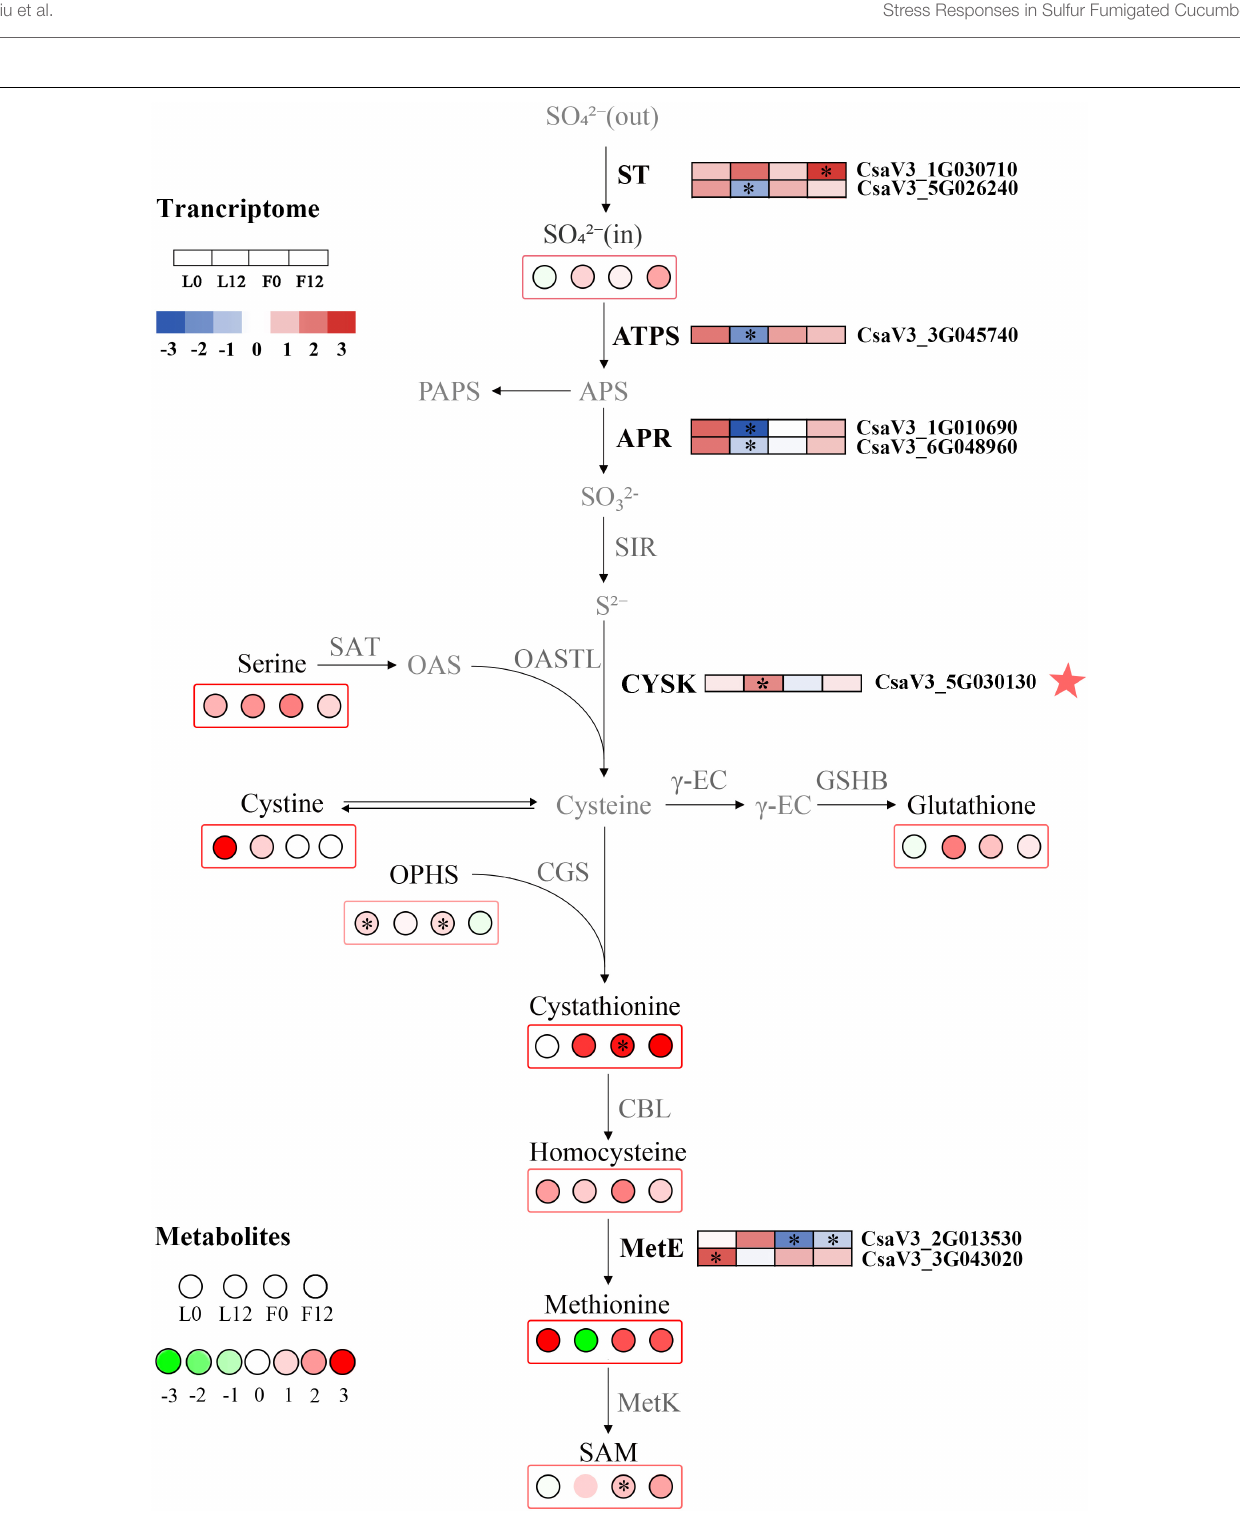
Frontiers in Plant Science |